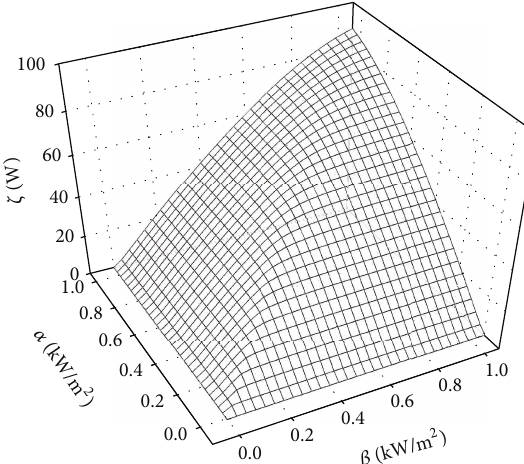
Figure 9: Three-dimensional view of the array maximum power 𝜁 as a function of 𝛼 and 𝛽 .